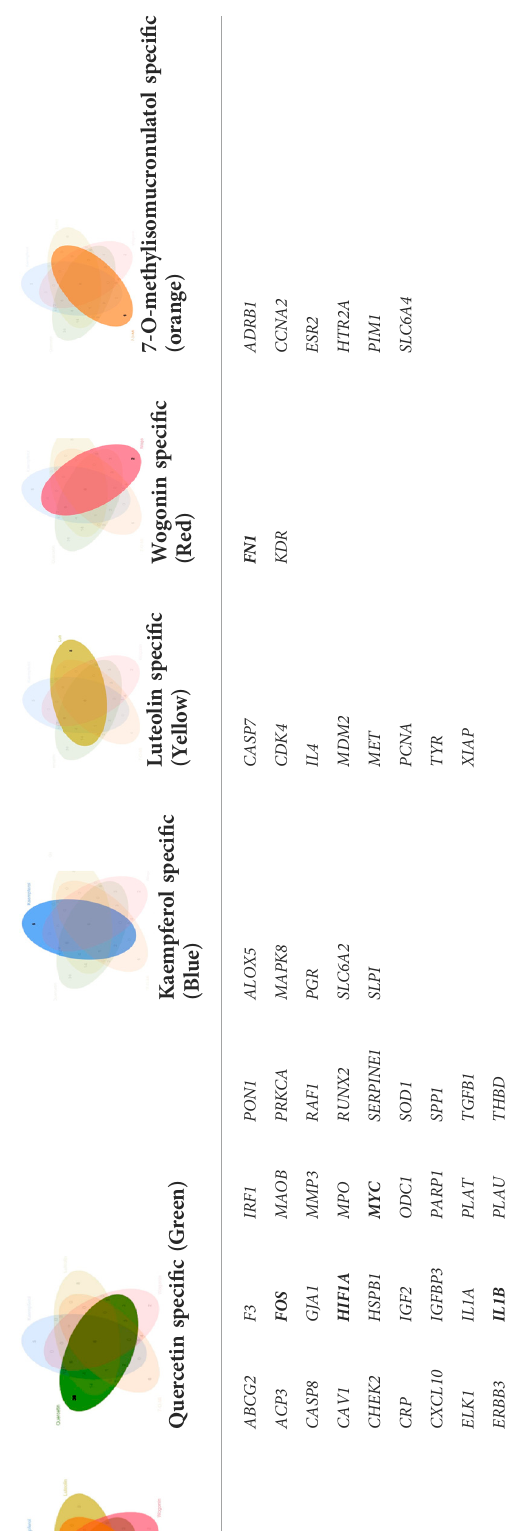
components. Ranking luteolin, wogonin, 7-O-